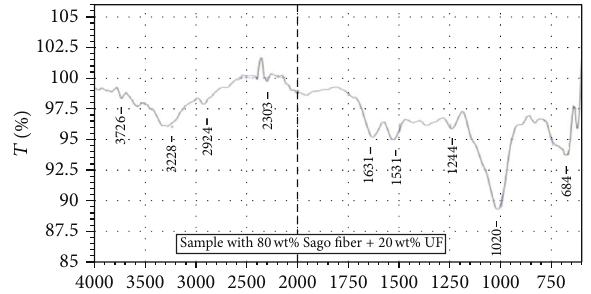
Figure 7: Sample E: Sago/UF Sample with 80 :